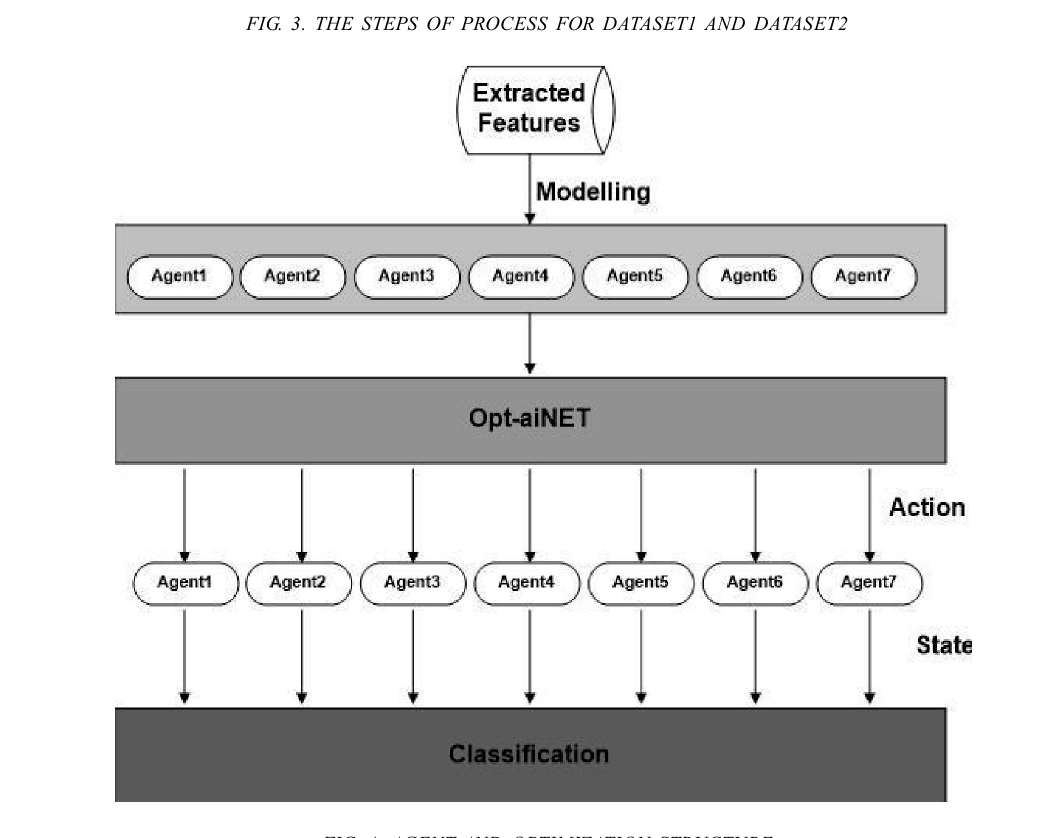
FIG. 4. AGENT AND OPTIMIZATION